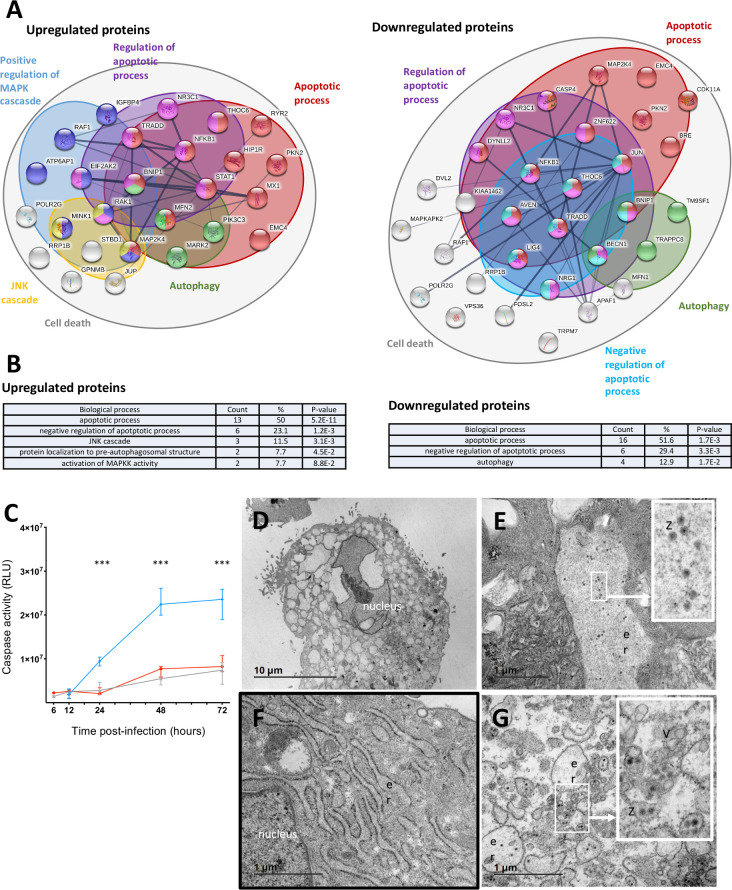
Exploration of ZIKV-induced cytopathic effects.Network representation (A) and gene ontology (B) of interacting proteins up-downregulated 48h after Pf13 infection compared to mock-infected (Up-downregulated proteins 48h after infection and involved in “Cell death”, “apoptotic cell death”, necrosis, autophagy, “necroptosis”, pyroptosis, MAP kinase cascade and JNK cascade were identified using Uniprot database. (A) Interaction analysis, STRING software; (B) Pathway enrichment analysis, DAVID software. (C) Caspase 3/7 activity measurement of mock-infected myoblasts (grey), ZIKV-infected myoblasts (red) and CHIKV-infected myoblasts (blue) at a MOI 1 (Promega Caspase-Glo 3/7 Assay kit). Results are expressed as median and interquartile range obtained from 4 independent experiments in triplicate. (D, E, F, G) Transmission Electron Microscopy was performed on mock (D) and infected (MOI = 1) myoblasts (B, C, E), 48h post-infection. er: endoplasmic reticulum, V: virus-induced vesicles, Z: ZIKV particle. Scale Bar: 10 μm (B), 1 μm (C,D,E).